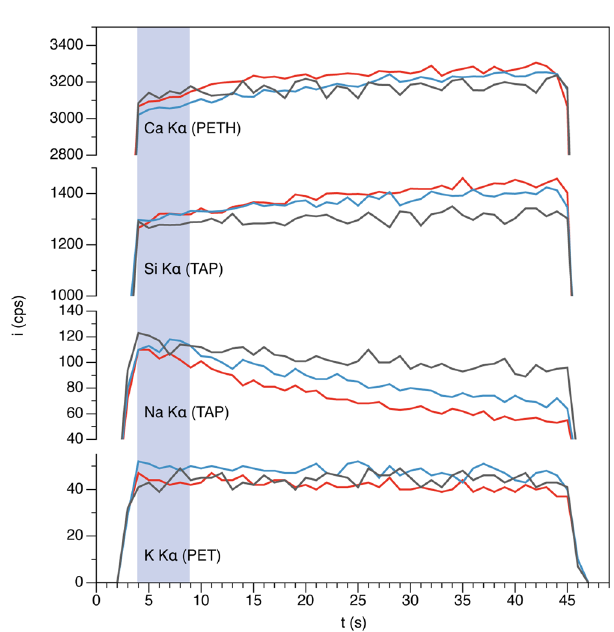
Fig. 2 | X-rayintensities (iin counts per second (cps))ofCa, Si, Na, and K onLc plotted against time using spot sizes of 5 μ m (grey), 2 μ m (blue), and 1 μ m (red). Also shown is the 5s EPMA integration time (grey area) used for the quan- ti fi cation of Lc and